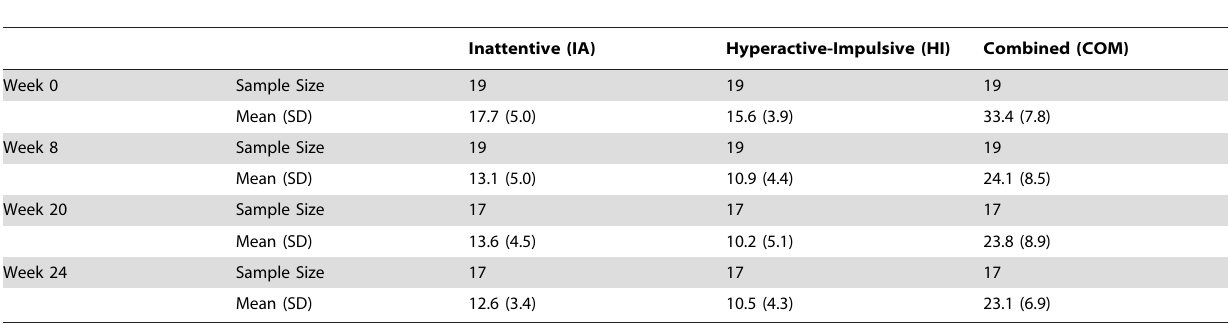
Table 1. ADHD rating scale IV (ARS-IV) inattentive (IA), hyperactive-impulsive (HI) and combined symptoms (COM) total raw scores as rated by